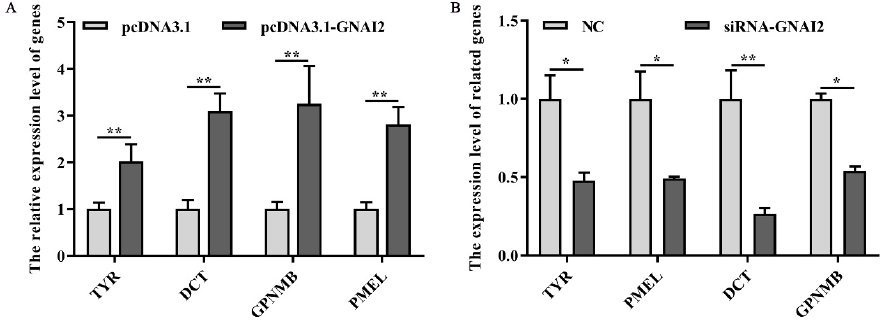
Figure 5. GNAI2 affected the expression of the downstream melanin-related genes: ( A ) qRT-PCR was performed to detect the mRNA expression levels of melanin-related genes in GNAI2-overexpressing melanocytes; ( B ) the expression of melanin-related genes was determined using a qRT-PCR after GNAI2 downregulation in melanocytes. *, p < 0.05; **, p < 0.01.